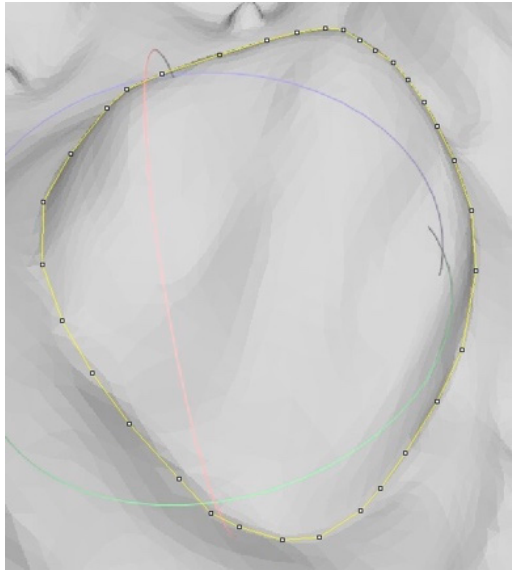
Figure 7. Tracing of perimeter of the palatal surface.